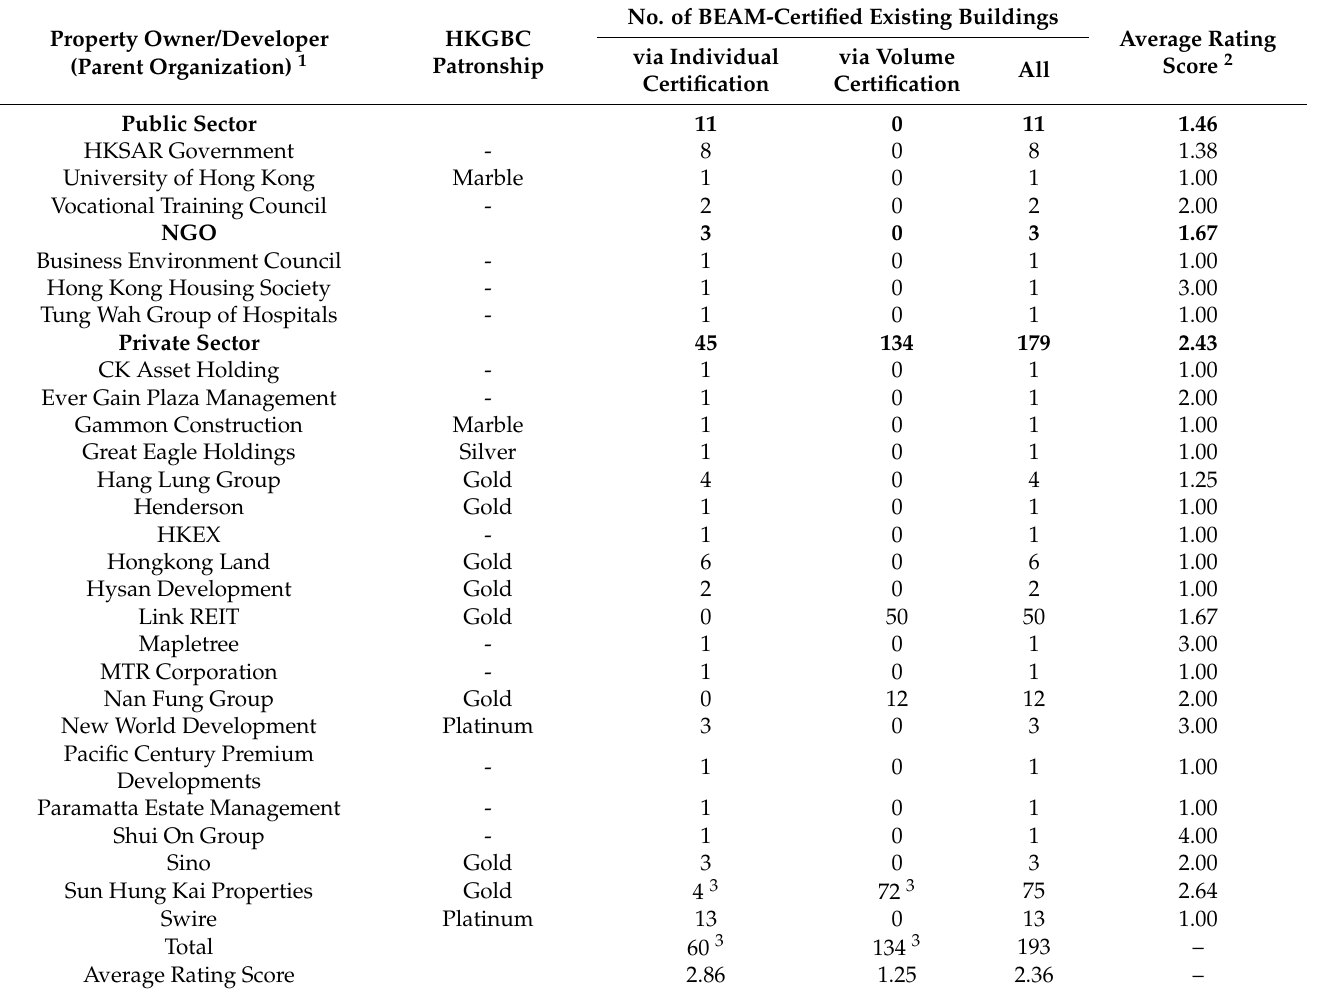
Table 4. Breakdowns of certified projects by developers or property owners (N =